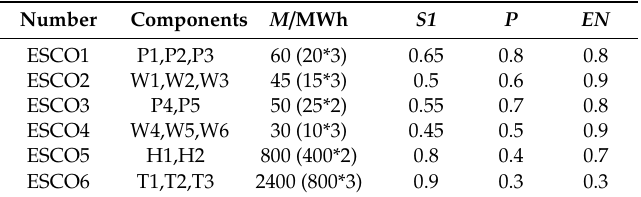
Table 4. Buy nodes in the EBN.